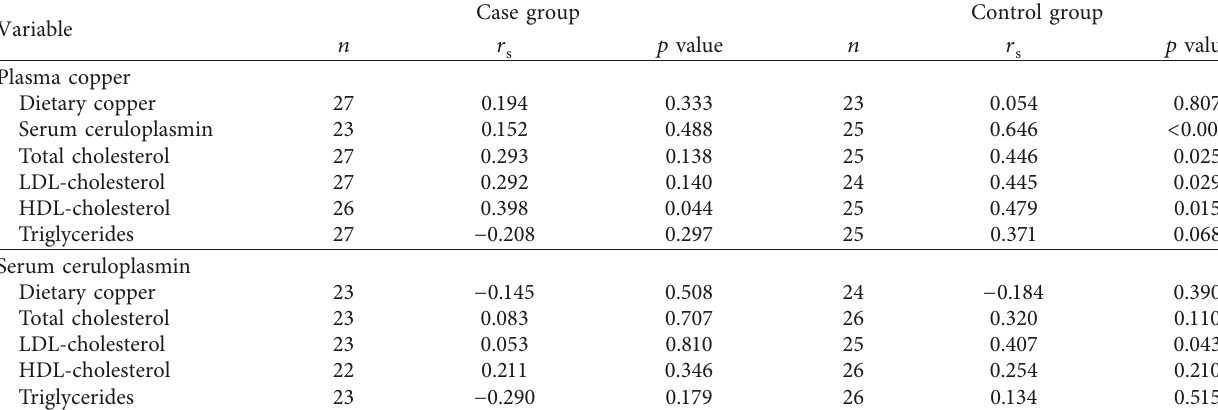
Table 2: Correlation of plasma copper and serum ceruloplasmin with dietary copper and lipid profile of the